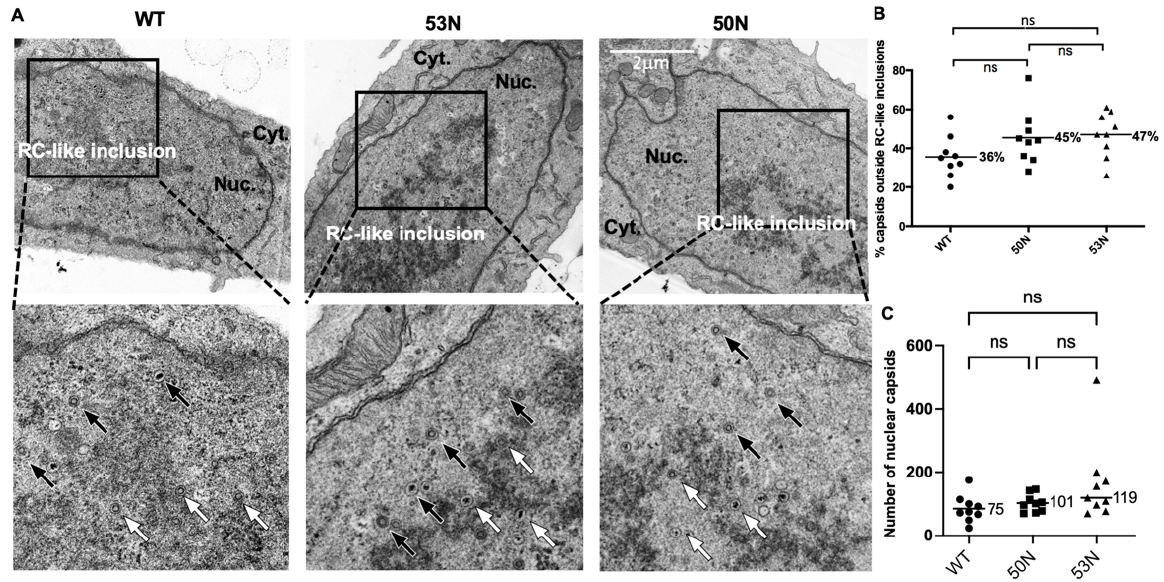
Figure 7. ( A ) HFFs were infected with WT, 50N, or 53N HCMV (MOI 1) and at 72 hpi cells were fixed and processed for EM. Black arrows point to capsids outside RC-like inclusions. White arrows point to capsids associated with RC-like inclusions ( B ) The percentage of capsids located outside RC-like inclusions was calculated in sections of 9 nuclei per condition and plotted. The horizontal bars indicate the mean percentage of capsids for each condition. p -values were calculated using ordinary one-way ANOVA corrected for multiple comparisons using the Holm–Sidak test (ns = not significant. WT vs. 50N, p = 0.18; WT vs. 53N, p = 0.16; 50N vs. 53N, p = 0.79). ( C ) The number of capsids found in the same sections analyzed in ( B ). The horizontal bars indicate the median numbers of capsids per section; the medians were calculated to obviate misleading skewing of the results by an outlying data point. Data were analyzed using a Kruskal–Wallis test with Dunn’s tests to provide p -values corrected for multiple comparisons (ns = not significant). WT vs. 50N, p = 0.8346; WT vs. 53N, p = 0.0806; 50N vs. 53N, p = 0.7768).